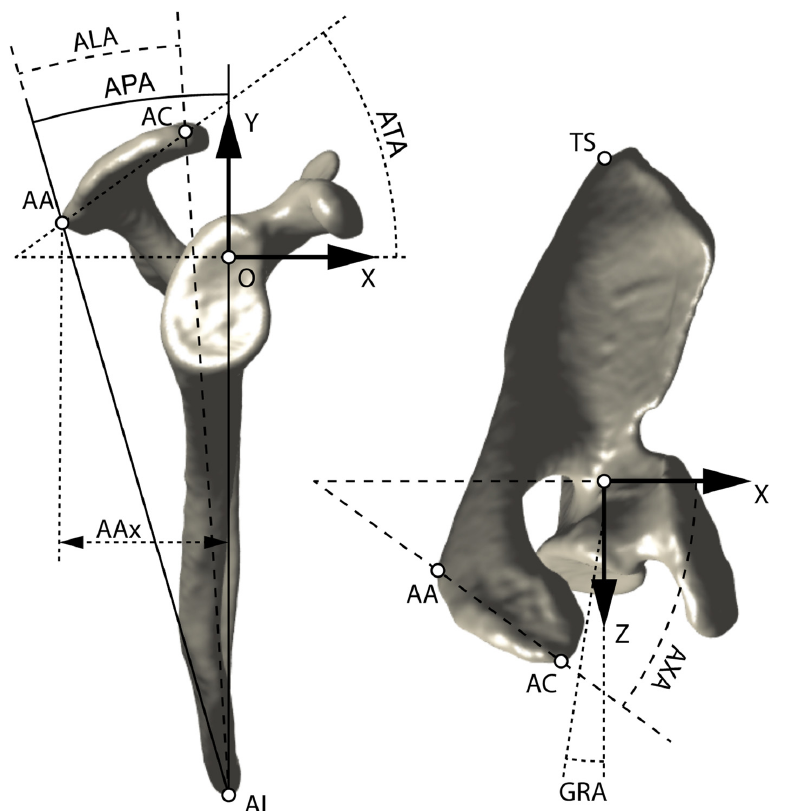
Figure 1. Anatomical description of the scapular coordinate system (OXYZ), acromion landmarks (AA, AC), trigonum spinae (TS), angulus inferior (AI), posterior extension of the acromion (AAx), acromion posterior angle (APA), acromion tilt angle (ATA), acromion length angle (ALA), and glenoid retroversion angle (GRA). The three axes ( x , y , and z ) correspond to postero-anterior, infero-superior, and medio-lateral, respectively.